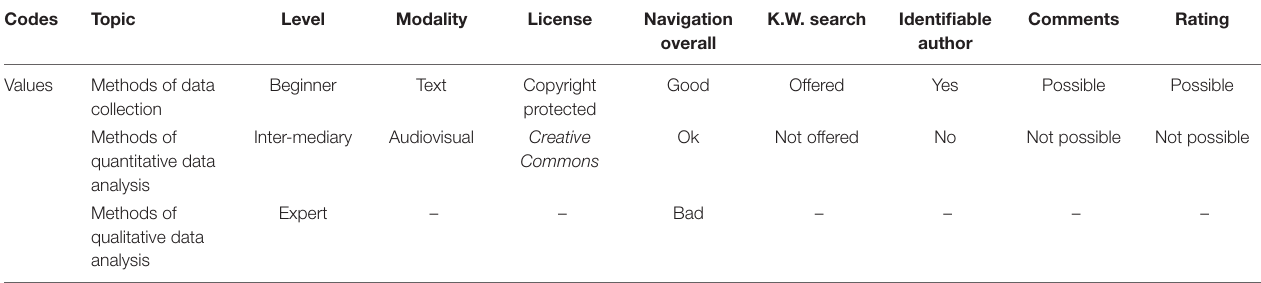
TABLE 1 | Categories for the evaluation of open educational resources